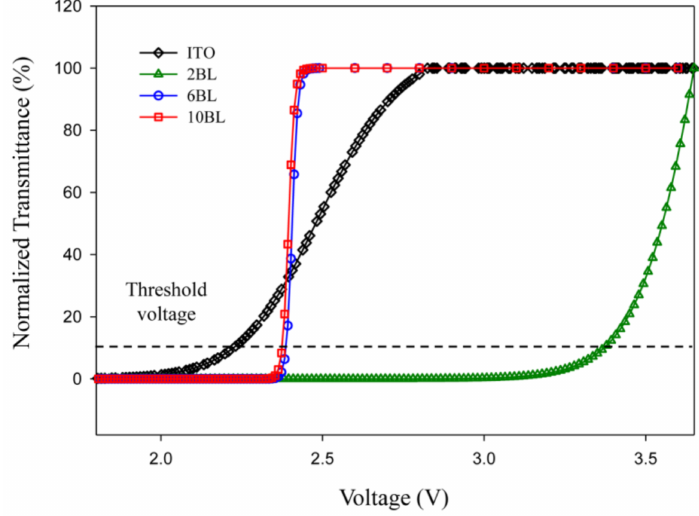
Figure 6. Voltage-transmittance (V-T) curves of VA LCD cells using 2-BL, 6-BL, 10-BL, and ITO